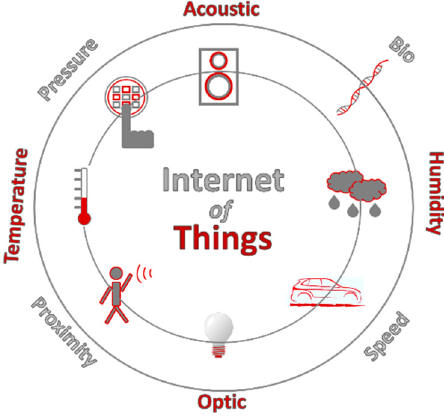
Figure 1. Some types of sensors used in IoT.